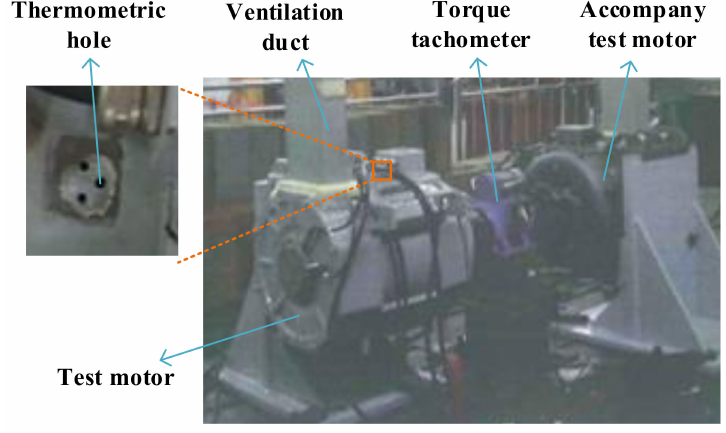
Figure 6. Test bench for motor experiments.